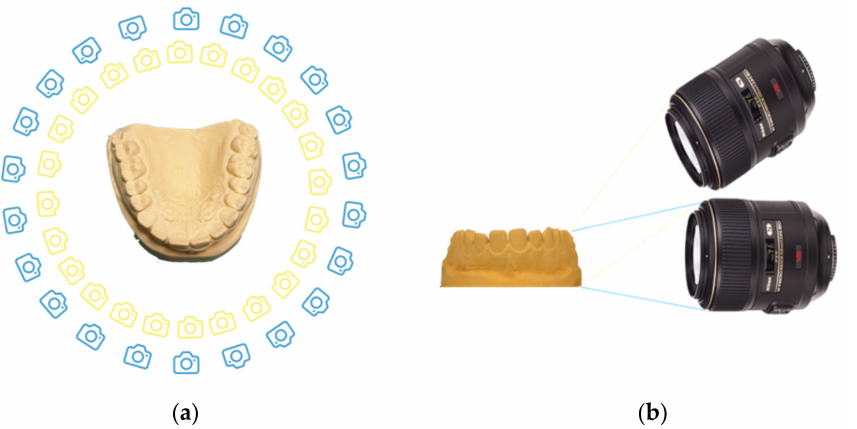
Figure 1. ( a ) Pattern of the realization of the photographs; ( b ) angulation of the camera: parallel to the occlusal plane and with an angle of 30 ◦